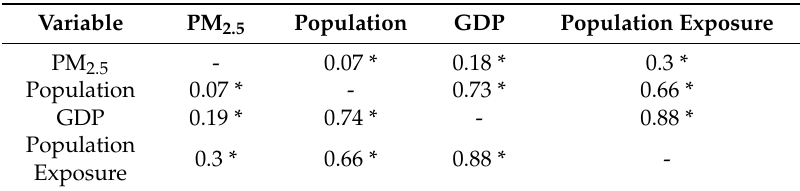
Table 1. The correlation matrix of the band collection